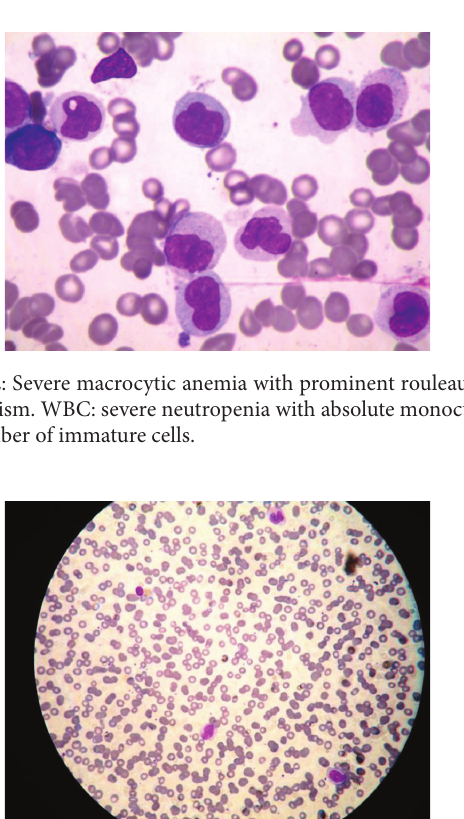
Figure 3: Bone marrow aspirate: Acute myeloid leukaemia with monocytic differentiation. The aspirate revealed leucopoiesis with prominent immature cells mainly monoblast and promonocytes occasional plasma cells. Depressed erythropoiesis with dyserythro- poietic